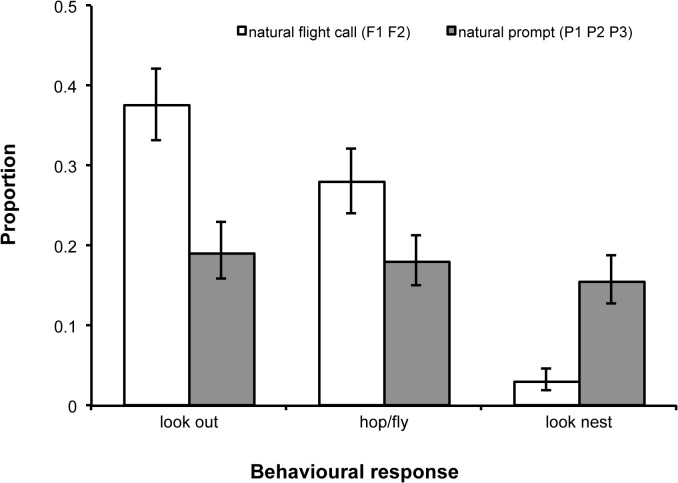
Responses to natural playbacks.Proportion of time spent engaged in three behaviours of functional relevance differed significantly during the playbacks of the two call types (see text). Figure shows back-transformed predicted means (± standard error [SE]) generated from three Generalized Linear Mixed Models (GLMM), in which the time engaged in each of the three activities (looking out of the aviary, in movement [hopping/flying], and looking at the nest) were fitted as three independent response terms. In each case, response terms were fitted to a binomial error structure with logit link function, time spent in camera view was fitted as the binomial denominator, call type (natural flight versus natural prompt) was fitted as a two-level factor, and individual identity nested within group identity were fitted as random terms.